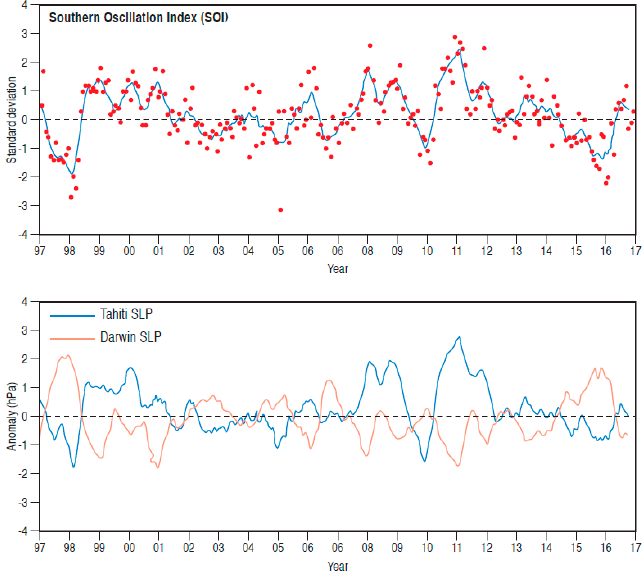
Figure 1. Time series of Southern Oscillation Index (SOI) and Tahiti and Darwin pressure, 1997–2016. Sourced and redrawn from the Climate Diagnostics Bulletin (http://www.cpc.ncep.noaa.gov/products/ CDB).